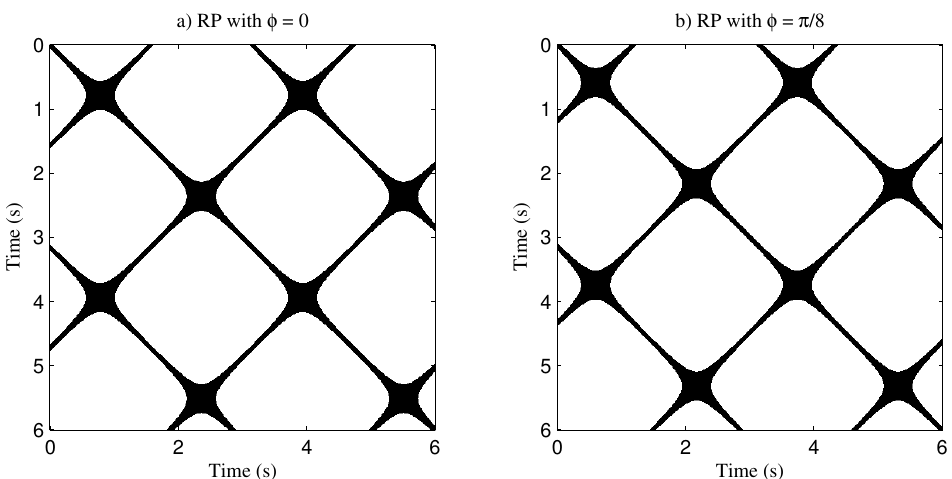
Figure 6. Recurrence plot for x = sin ( 2 t + φ ) : ( a ) without phase shift ( φ = 0); ( b ) with phase shift ( φ = π /8).